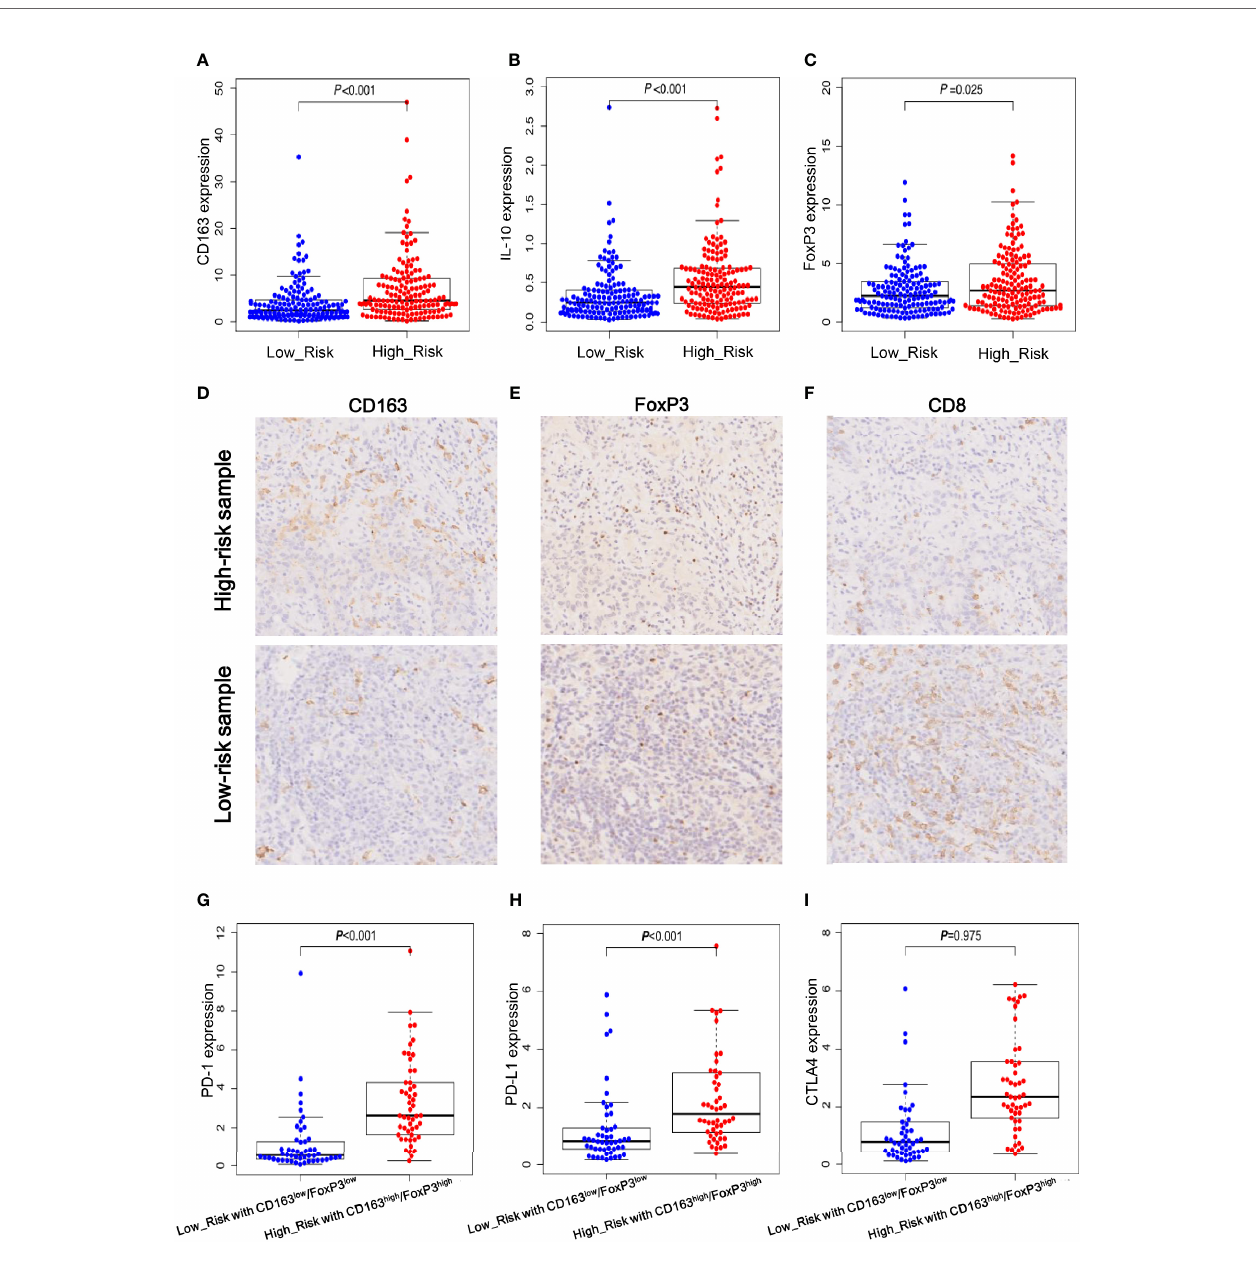
FIGURE 6 | Immune-related gene expression and validation in gastric cancer specimens. (A, B) The mRNA expression levels of CD163 and IL-10 which are the well-documented markers of M2 polarized cells. (C) The mRNA expression levels of FoxP3 that is a critical for Treg function. (D – F) Immunohistochemistry (IHC) staining results of CD163, FoxP3 and CD8 proteins in high- and low-risk gastric cancer samples. (G – I) The mRNA expression levels of immune check-point PD-1, PD-L1 and CTLA4 in low-risk group with low expression levels of CD163 and FoxP3 and in high-risk group with high expression levels of CD163 and